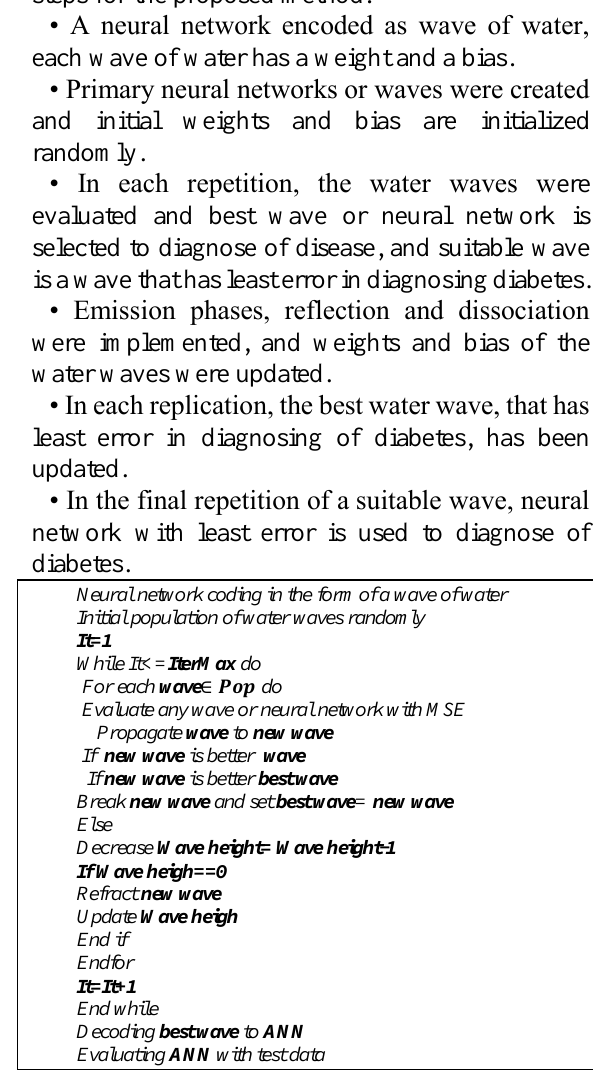
Figure 6. The pseudo code proposed for the diagnosis of diabetes.